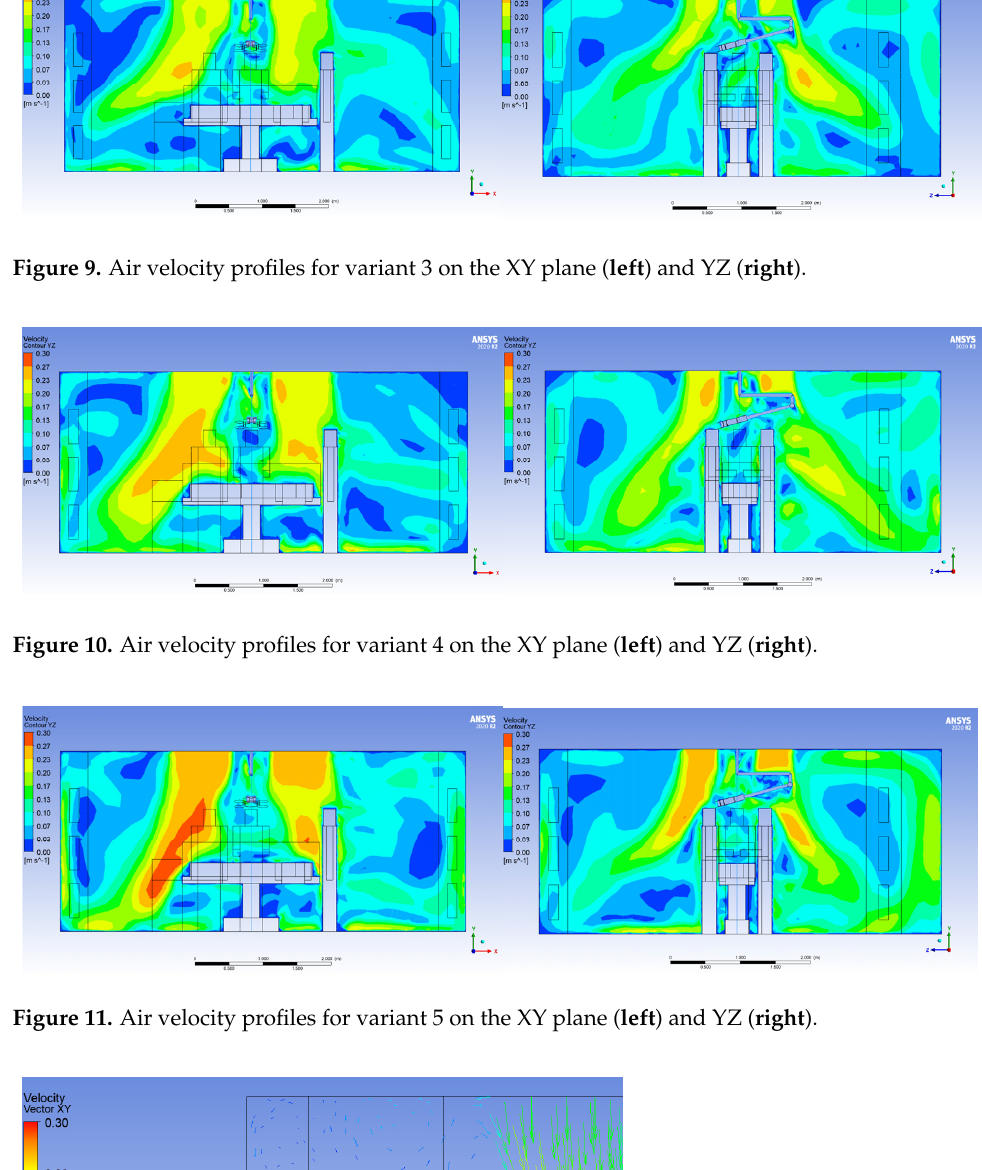
Figure 8. Air velocity profiles for variant 2 on the XY plane ( left ) and YZ ( right ).